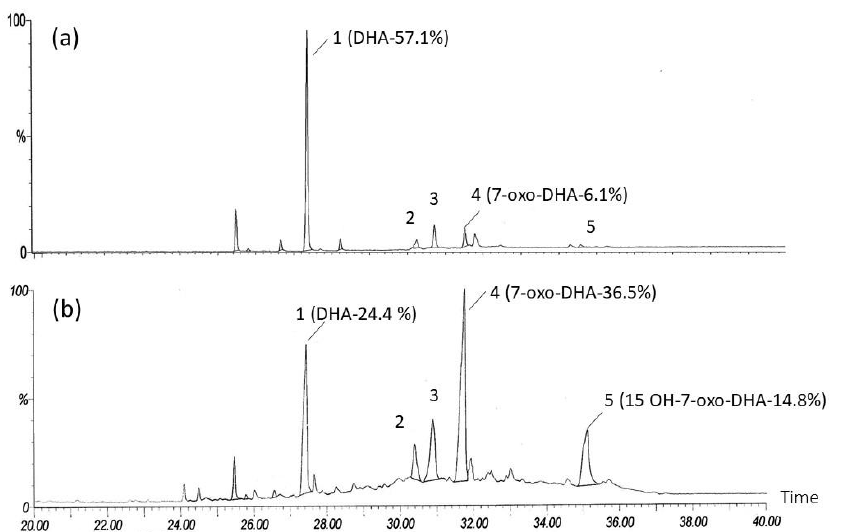
Figure 3. Chromatograms corresponding to ( a ) colophony varnish treated with Benzalkonium chloride and inoculated with B. amyloliquefaciens (type 4) and ( b ) colophony varnish not treated with biocides but inoculated with B. amyloliquefaciens (type 3). Values expressed in Ni . 1: DHA = dehydroabietic acid; 2: 7-OH-dehydroabietic acid; 3: 15-OH-dehydroabietic acid; 4: 7-oxo- dehydroabietic acid; 5: 15-OH-7-oxo-dehydroabietic acid.